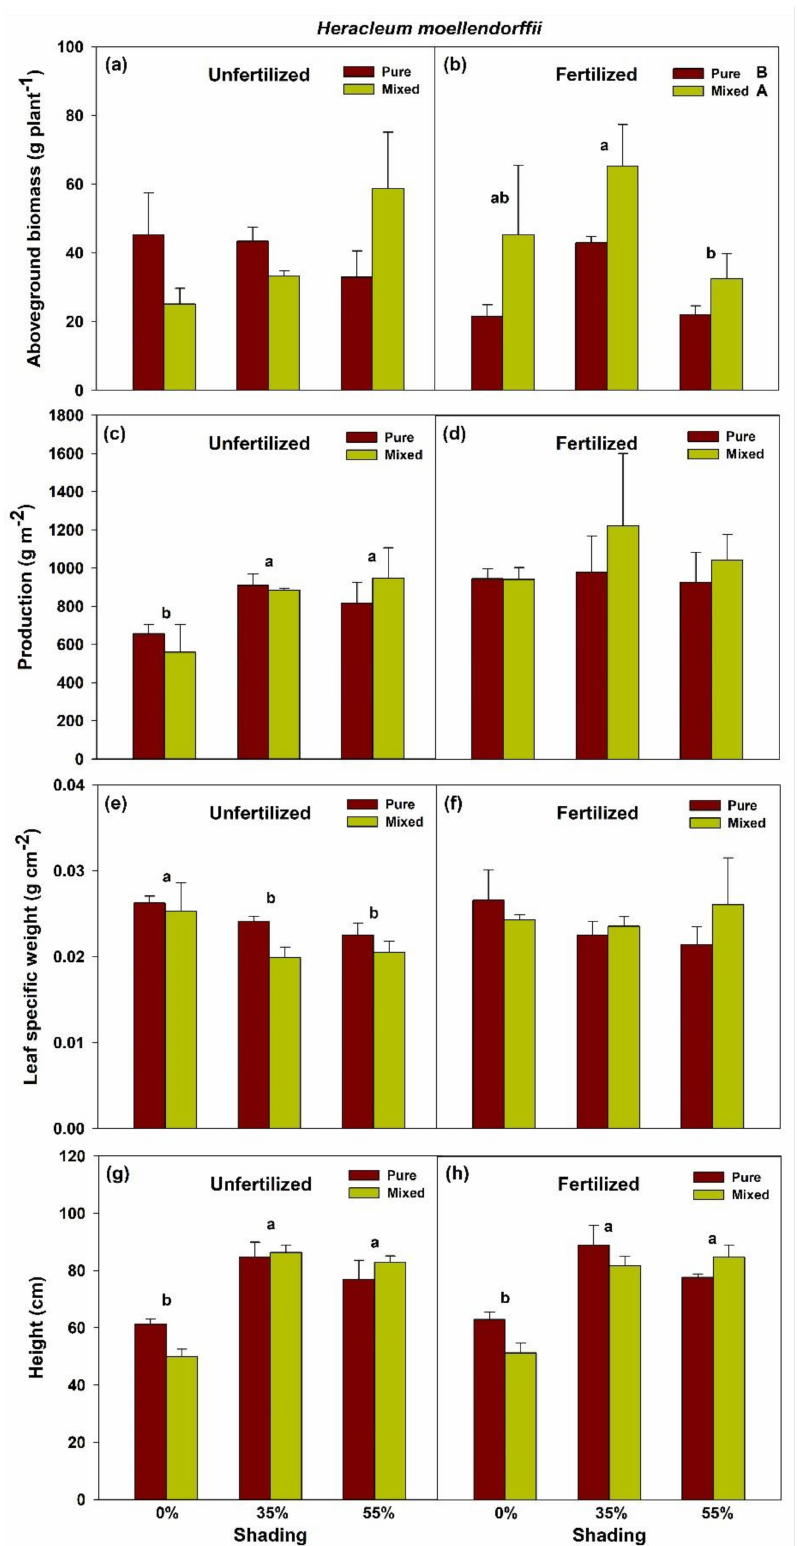
Figure 1. Aboveground biomass ( a , b ), shoot production ( c , d ), leaf-specific weight ( e , f ), and height growth ( g , h ) of pure Heracleum moellendorffii and mixed Heracleum moellendorffii + Adenophora divaricata in different light and fertilization treatments. Different lowercase and uppercase letters indicate statistical significance across shade treatments and between planting methods, respectively. Vertical bars show standard errors ( n =